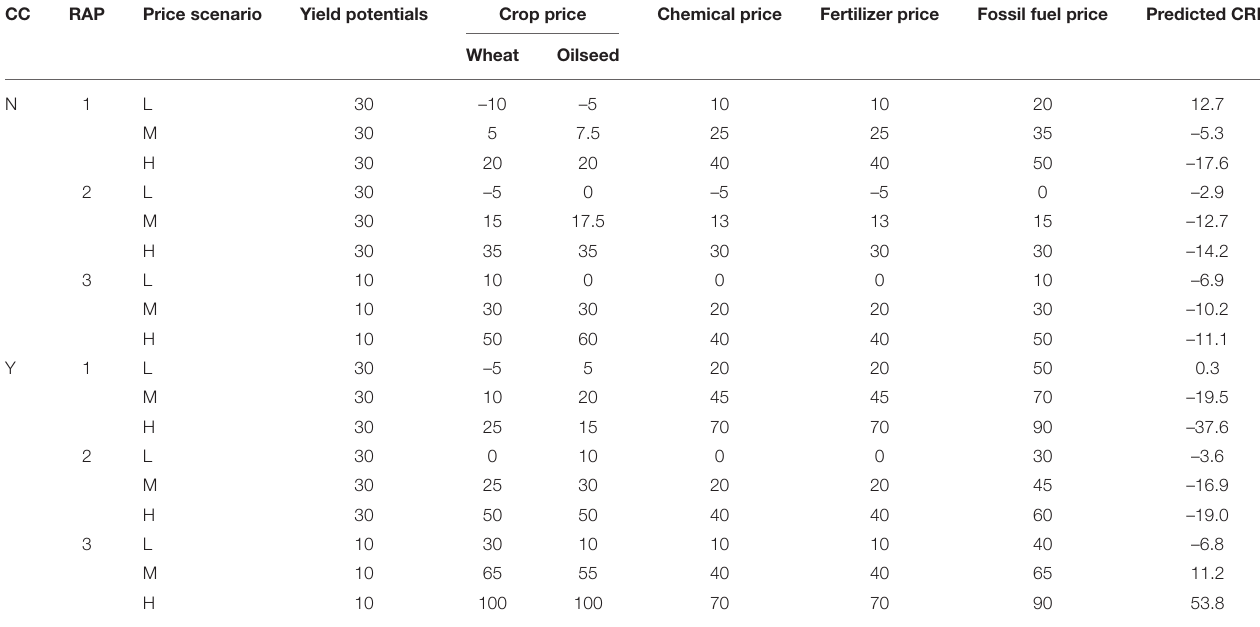
TABLE 3 | Assumptions of changes in yield potentials and input and output prices for cost-over-revenue ratio (CRR) prediction and economic impact simulation (%). CC